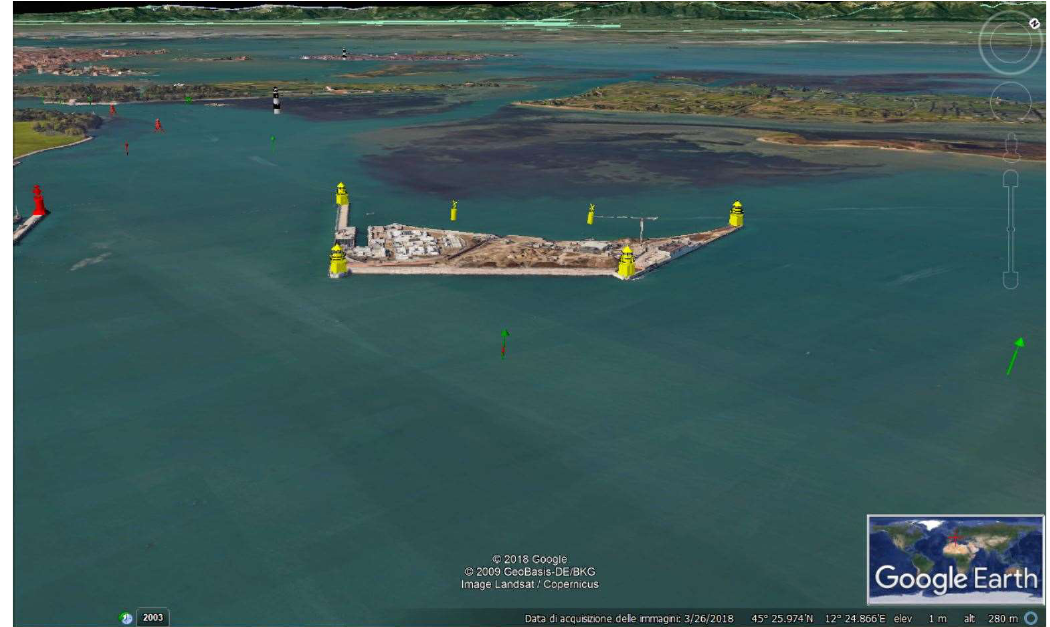
Figure 2. View of the artificial island (Port of Lido). SketchUp models simulate the expected situation.